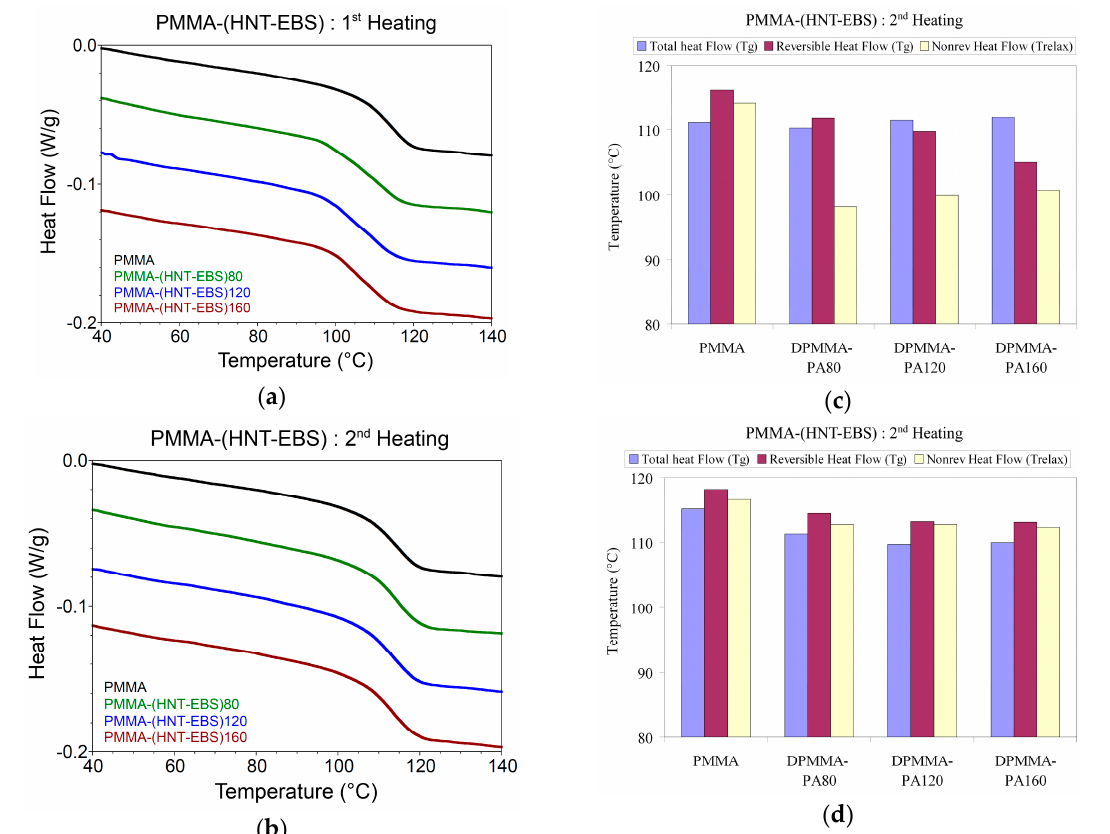
Figure 5. PMMA chain transition ( T g , T relax ) in the HNT–EBS final nanocomposites. DSC thermograms: ( a ) the 1st heating and ( b ) the 2nd heating). T g (from the Total and Reversible Heat